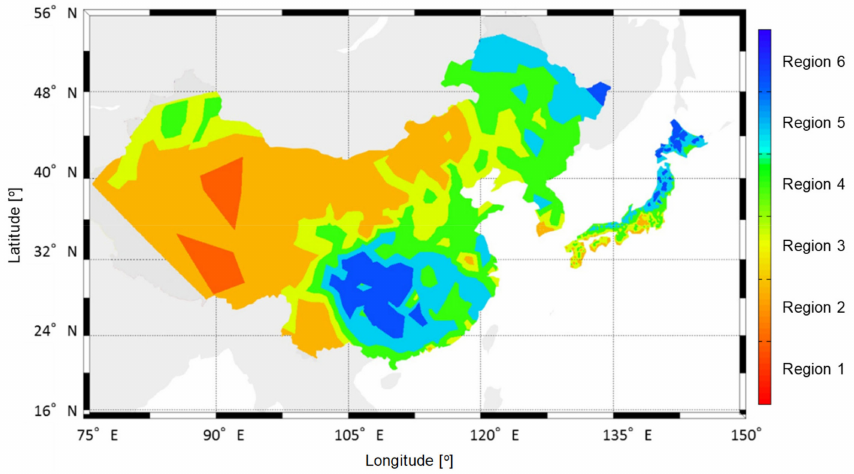
Figure 8. Classification by daily solar global horizontal irradiance (based on Table